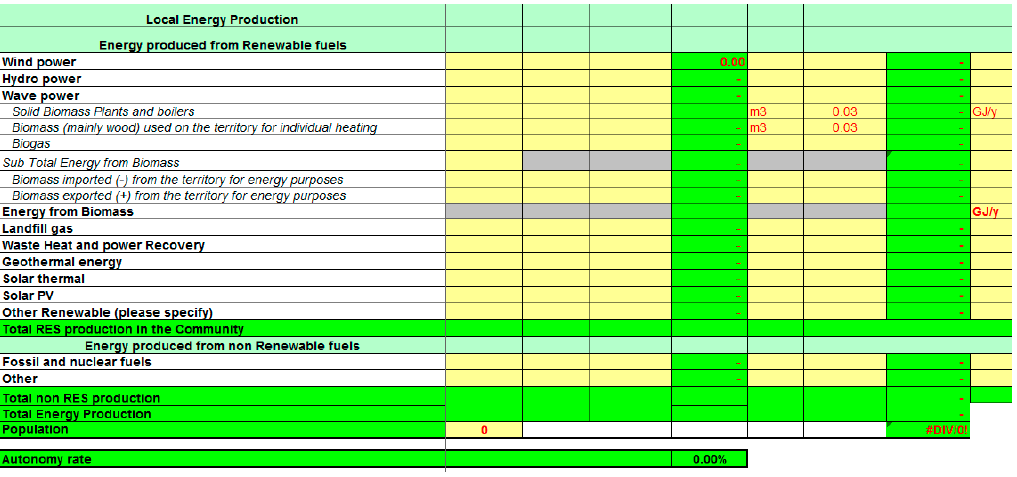
Figure 9. The local energy production.